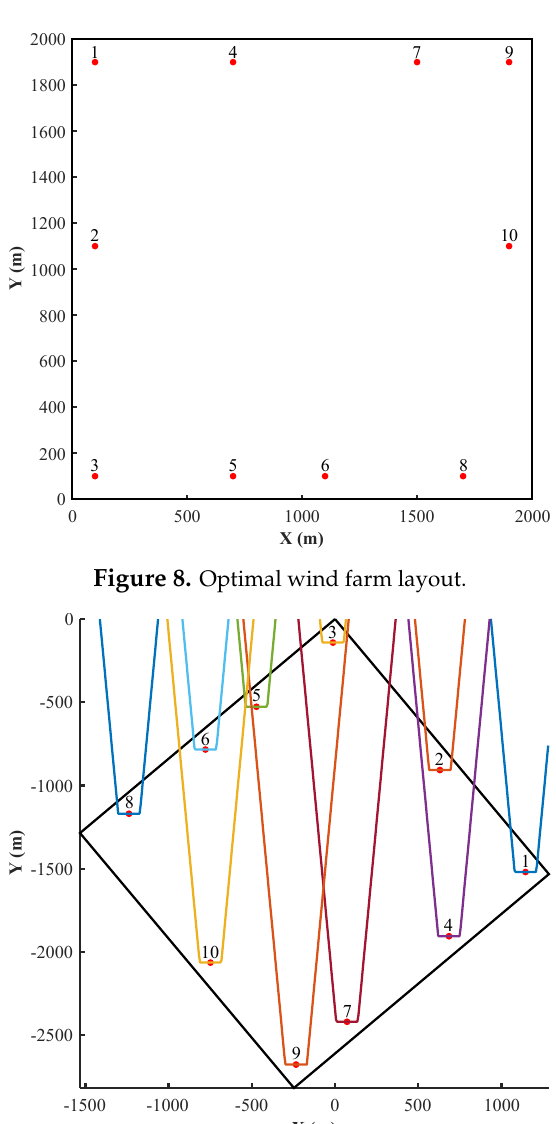
Figure 9. Wake effects for a wind direction of 220 ◦ .